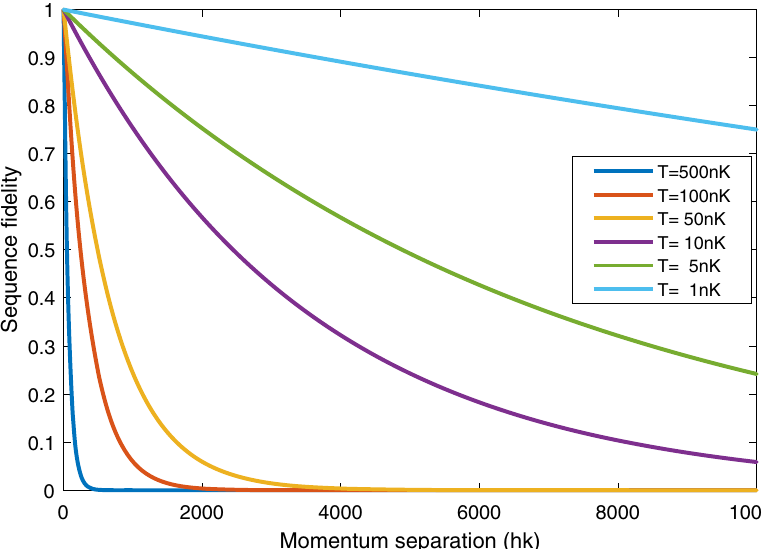
Fig. 5 Pulse sequence fi delity. Fidelity of the entire LMT (large momentum transfer) sequence as a function of momentum separation, for various atomic temperatures. The sequence fi delity is obtained as the cumulative product of individual pulse fi delities, which are obtained by averaging the transition probability over the cloud instantaneous spatial and velocity distributions. The initial cloud radius is 200 μ m and the beam radius is 1.5 cm. To obtain a suf fi cient contrast at the end of the 10 4 ℏ k LMT sequence, a cloud temperature less than 10 nK is required. Cloud expansion, Doppler shift compensation and spontaneous emission are included in the model. The pulse bandwidth is neglected, but any resulting errors can be compensated with frequency and intensity adjustments 55,56